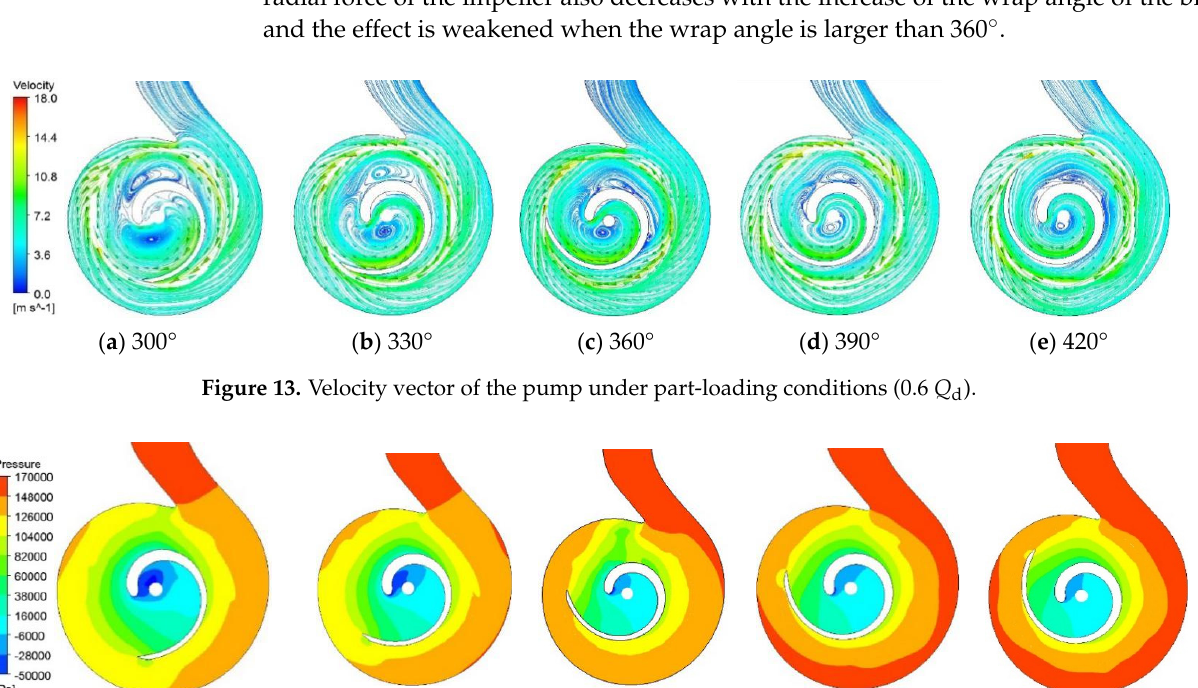
Figure 14. Pressure distribution in the pump under part-loading conditions (0.6 Q d ).